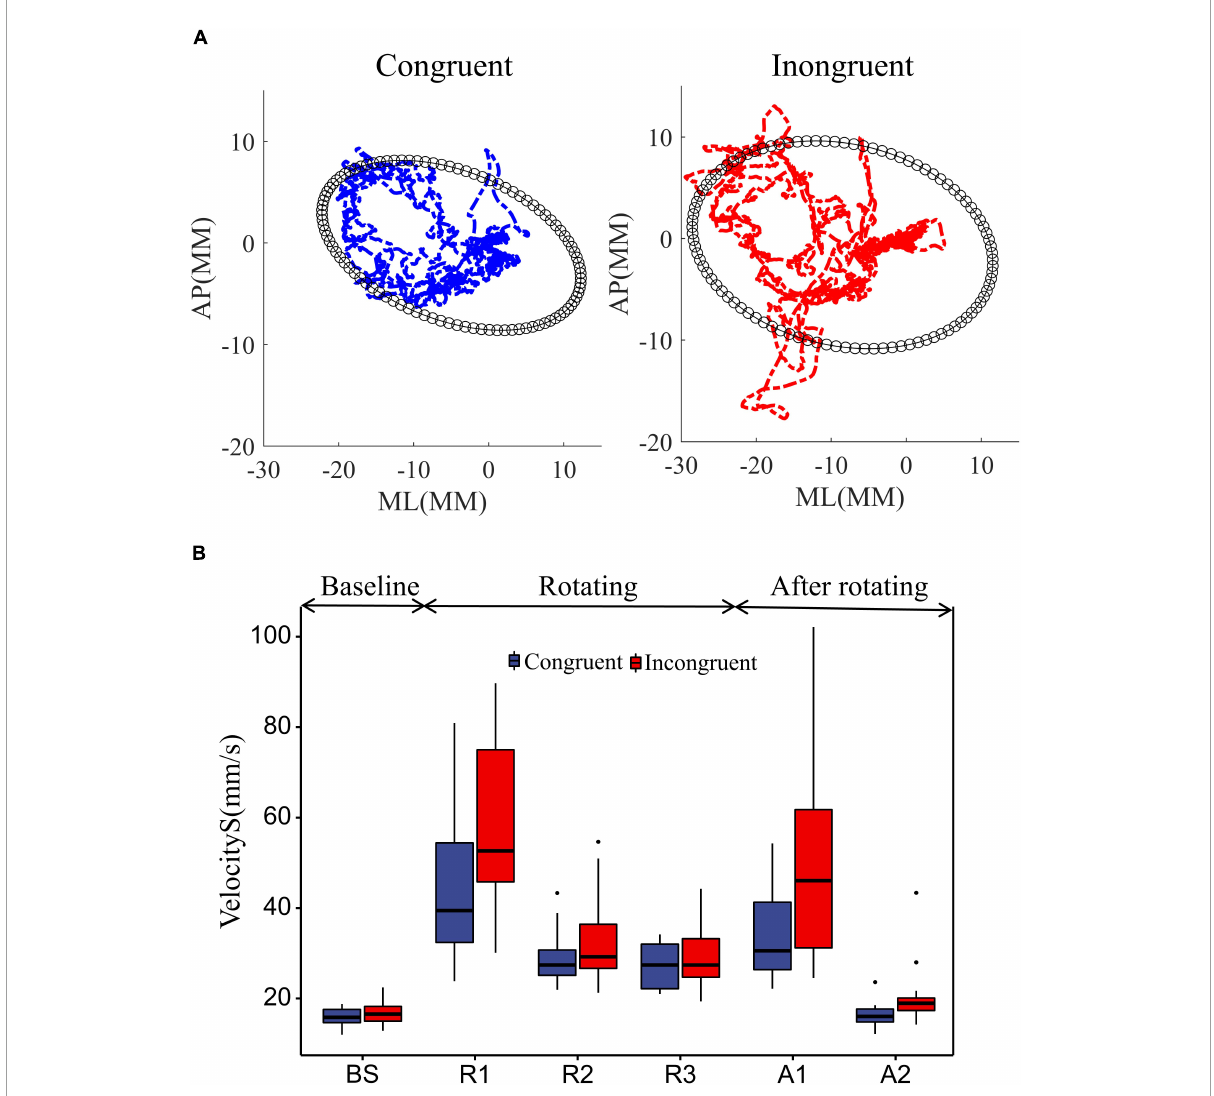
FIGURE3 Effect of rotational stimuli on stance stability. (A) The mean COP sway trajectories and area for all 18 participants. The blue and red curves represent the mean COP trajectories in the congruent and incongruent conditions, respectively. The black ellipse quantifies 85% of the total area covered in the ML and AP directions, using the ellipse to fit the data. (B) Comparative analysis of participant sway velocities between congruent and incongruent conditions. According to the starting and ending points of the rotating stimuli, we divided the COP data into BS (12 s before platform initiation), R1 (0–12 s after platform initiation), R2 (12–24 s after platform initiation), R3 (24–36 s after platform initiation), and A1 (0–12 s after platform stop), A2 (12–24 s after platform stop). We used two-way repeated measures ANOVA to assess the effects of the time window and sensory condition on standing posture stability. Differences in COP sway velocity within rotating phase (R1, R2, R3) and after rotating phase (A1, A2) were assessed with two-way repeated measures ANOVAs with sensory condition (incongruent, congruent) and time window. Differences in COP sway velocity during the movement state transitions were assessed with repeated measures ANOVAs, which compared the baseline to the mean of the rotating and after rotating phases in both sensory conditions. In ANOVAs, predicted effects and/or interactions were explored further with simple effects analyses, and unexpected effects were explored further with Bonferroni post-hoc tests. The upper and lower error bars of the bins are the upper and lower quartiles of the data, respectively.